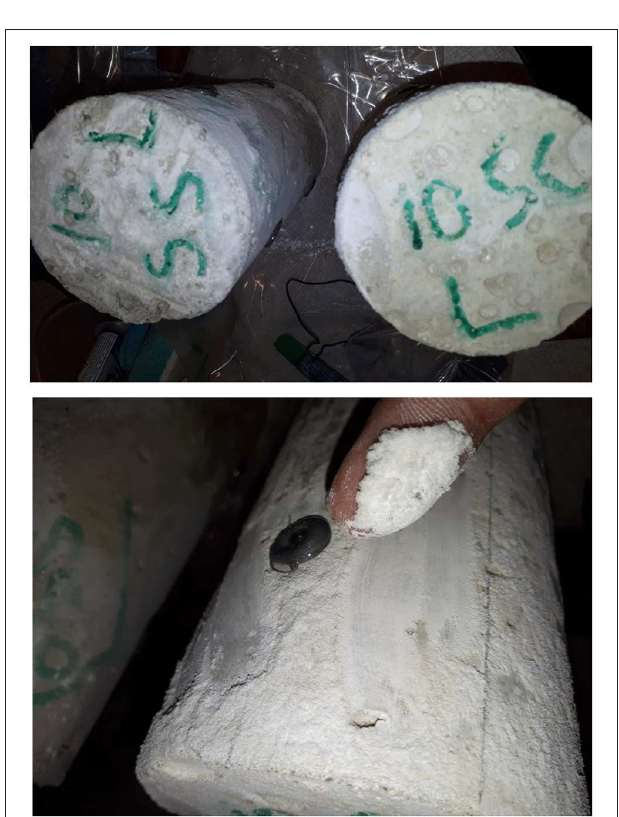
FIGURE 8 | SEM-BSE images of fragments of 28 days (sealed) AAS concrete samples show the microcracking which filled with resin.The right side shows the lab-cured samples (marked L), and the left side shows the heat-cured samples (marked H). Agg., aggregate particle; BFS, unreacted or partially reacted blast furnace slag particle. The scale bar in each image represents 50 µ m.